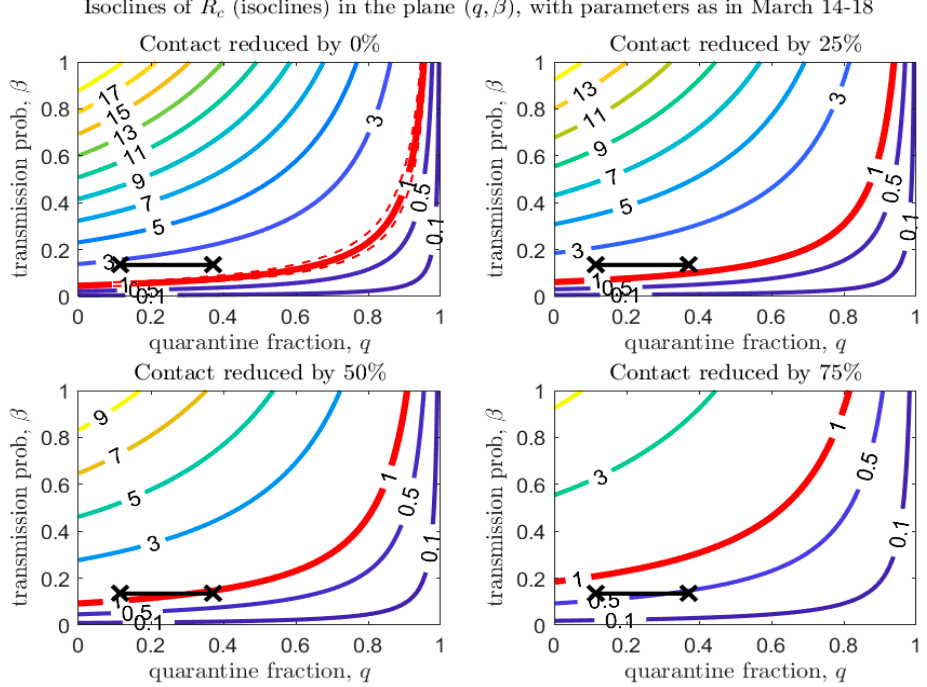
Figure 7. Values of R c in the plane ( q , β ) , with baseline parameters estimated on March 24 (top-left panel), and under di ff erent scenarios of contact rate reduction (other panels). The red line corresponds to R c = 1 (with dashed lines showing confidence intervals in the baseline scenario). The black crosses correspond to the parameters (max / min) estimated after March 24 (last day of the estimation period is April 21).